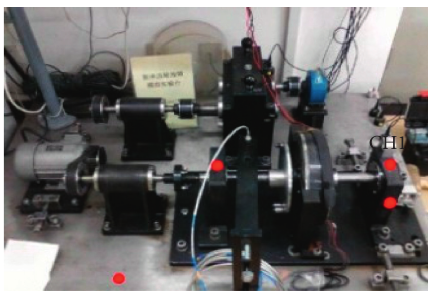
Figure 5: Fault test bench of a REB. Table 1: The theoretical fault characteristic frequencies of different bearing